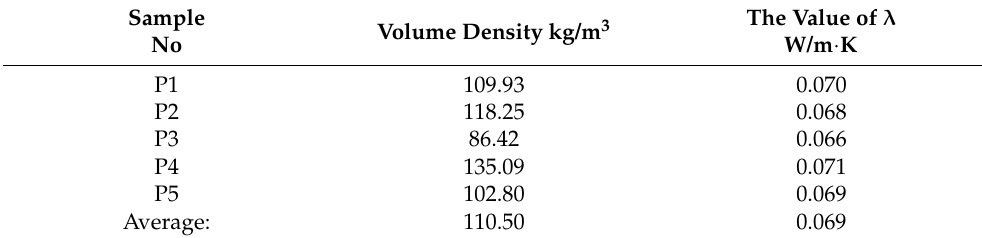
Table 2. Comparison of density and heat transfer ( λ ) values for straw test pieces with stem orientation perpendicular to heat flow direction.